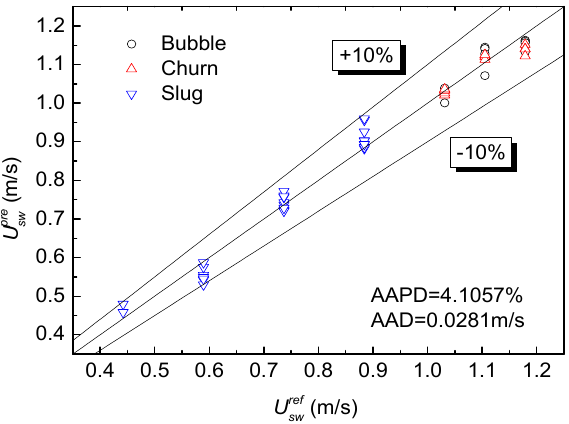
Figure 10. Prediction of water superficial velocity in an EMF–REFCS measurement system.